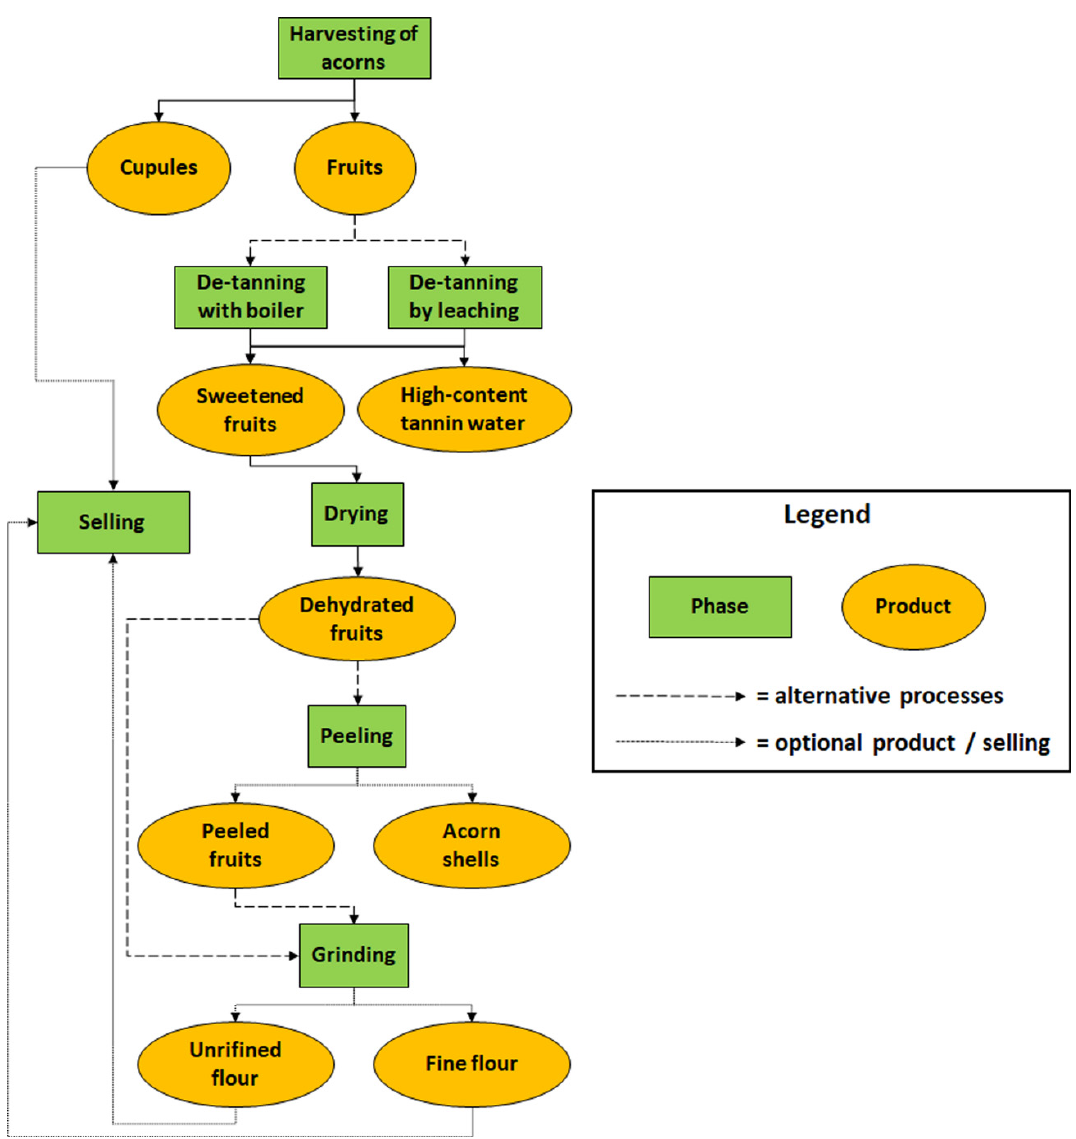
Figure 1. General framework of production process of acorn flour.